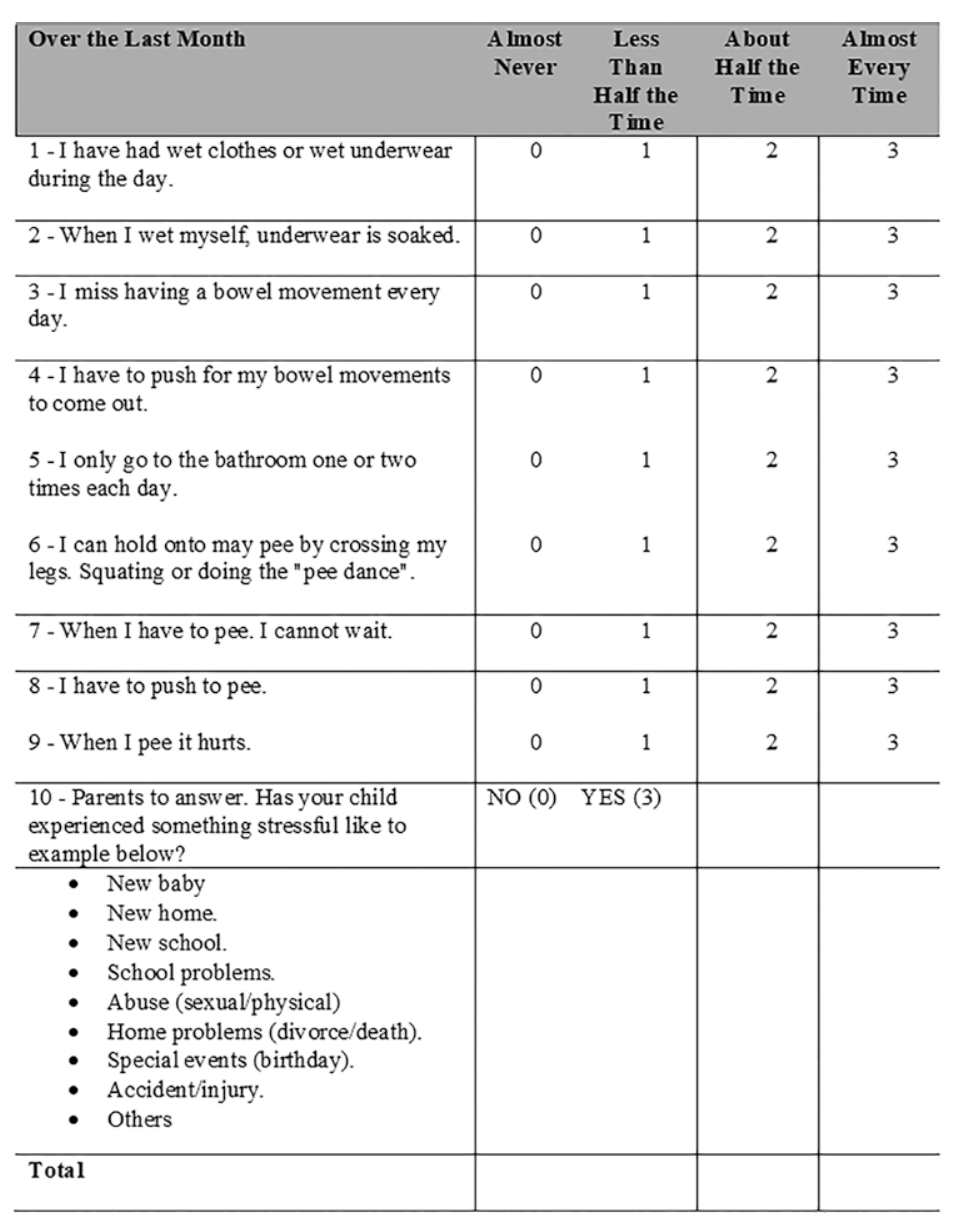
Figure 2 - Dysfunctional Voiding Scoring System (DVSS) adapted from Fahart et al. (13) and Calado et al.